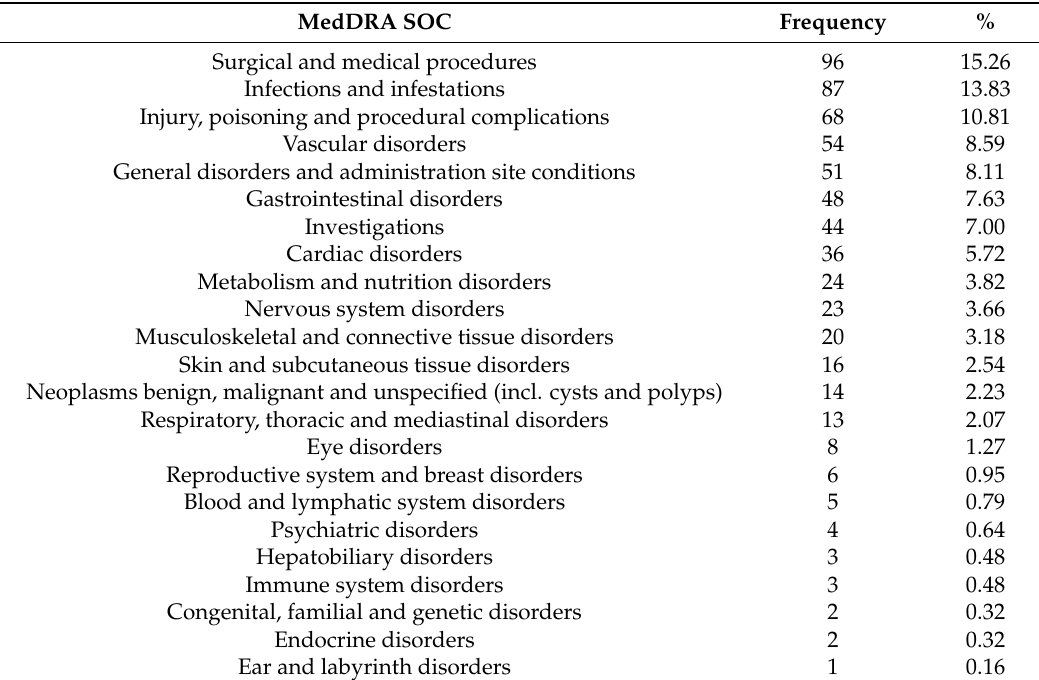
Table 18. Overview of AEs occurring in dialysis